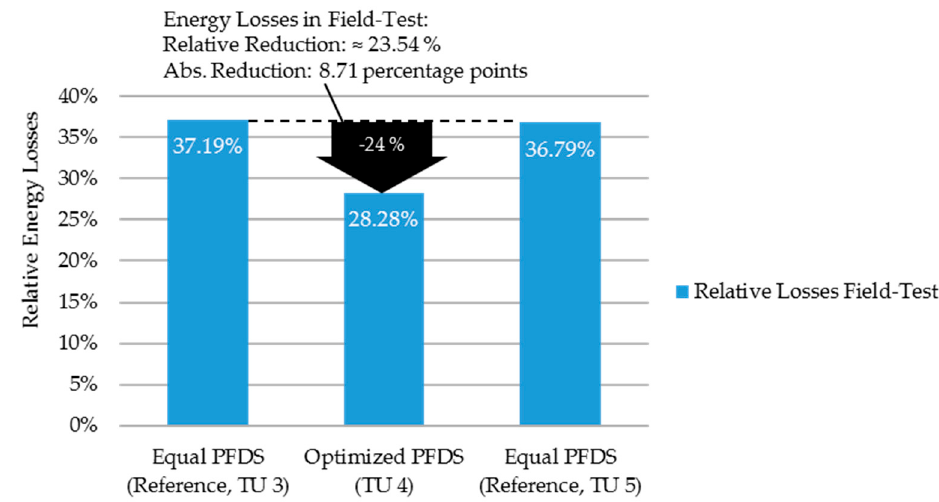
Figure 11. Field-test results for energy losses in TUs 3–5 for 3–14 August 2017. TU 3 and TU 5 operate on equal Power Flow Distribution Strategy (PFDS); TU 4 operates on optimized PFDS.